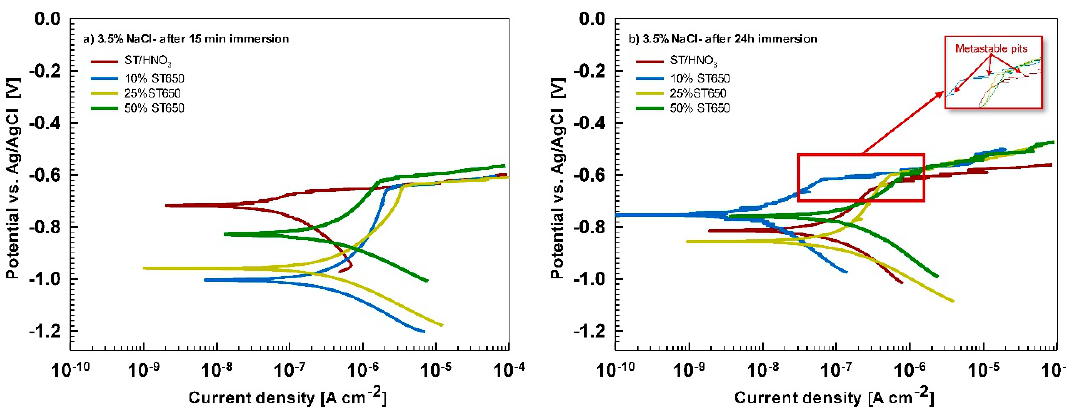
Figure 6. Potentiodynamic polarization curves recorded for uncoated, chemically pre-treated AA3003 (ST / HNO 3 ) and coated with ST650 coatings of di ff erent concentrations at a conversion time of 18 min at room temperature. The curves were recorded in 3.5% NaCl solution: ( a ) after 15 min immersion; ( b ) after 24 h immersion. The scan rate was 1 mV /